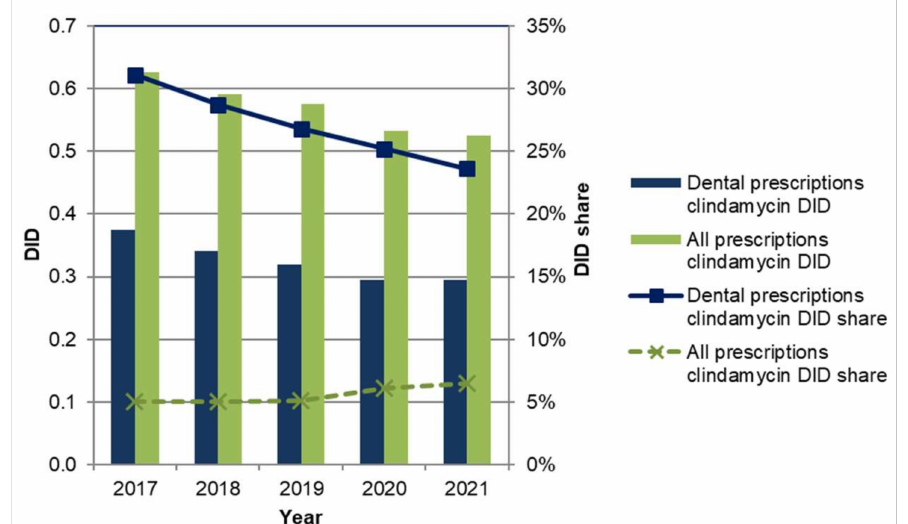
Figure 2. Trends for dental and all clindamycin prescriptions in primary